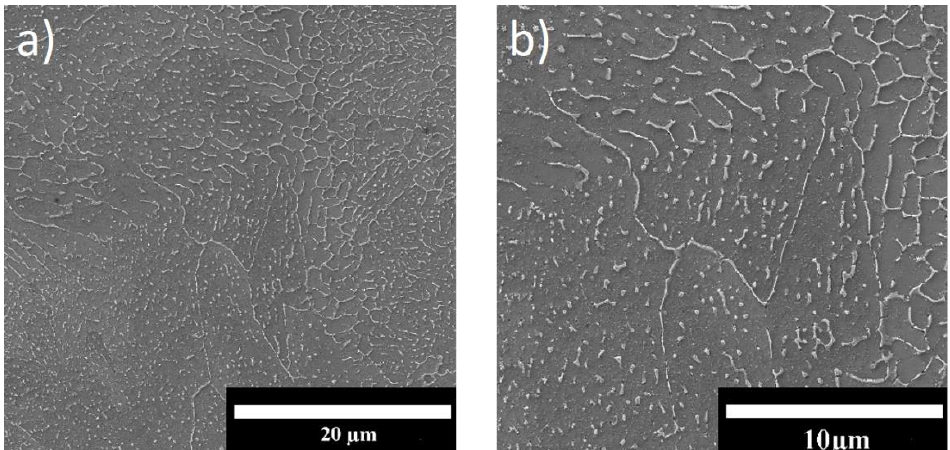
Figure 9. SEM images of RS-333 alloy microstructure following SLM printing and aging: ( a ) low and ( b ) high magnifications. Surface appearance of an X-Z sample is represented in Figure 10, revealing relatively large (200–400 µ m) and smooth clusters of molten material decorated with wrinkles and rare cracks, as well as the inclusion of non-molten powder particles. The rest of the supports are visible at the bottom edge of the gauge, where the clusters are apparently coarser and appear to be more separated with voids than in the middle zone of the gauge. These locations and support-free surfaces did not undergo stable continuous laser scanning and powder fusion. In contrast, the metallographic examination of the specimens’ core (stable laser scanning and powder fusion) revealed residual porosity only (Figure 8) and no traces of unfused powder.